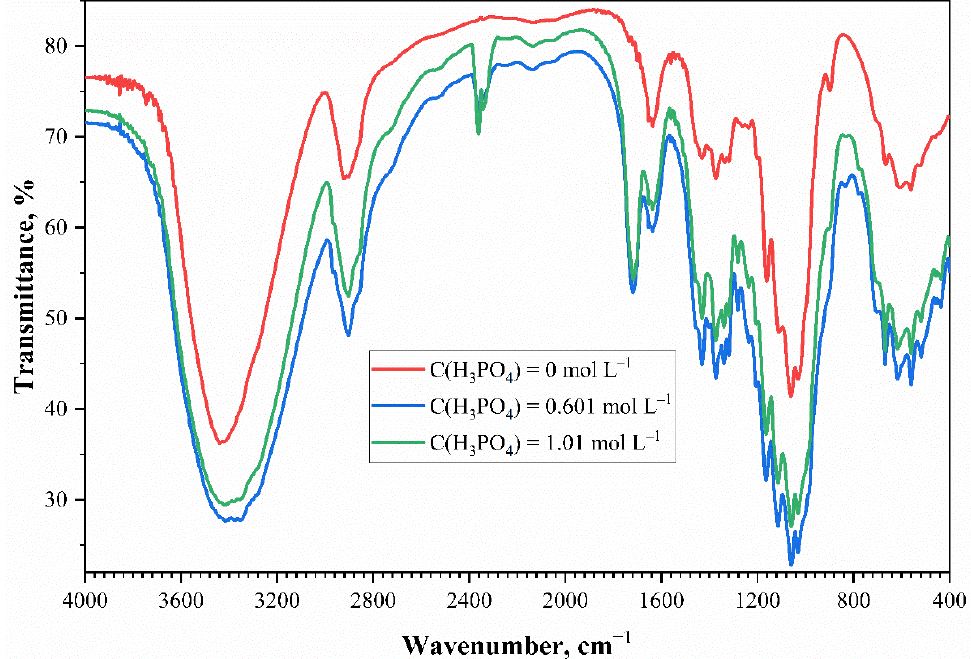
Figure 3. The IR spectrum of the mercerized cotton cellulose and the phosphorylated-cotton, cellulose-treated solutions with different phosphoric acid concentrations.